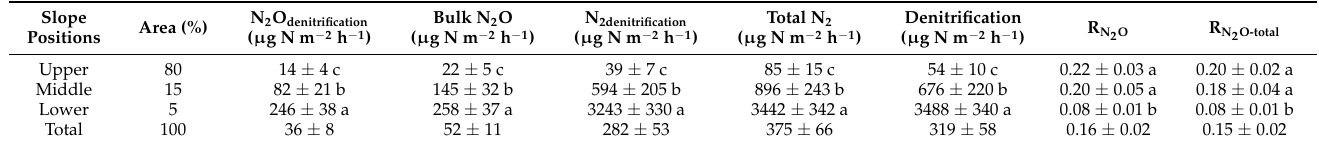
Figure 4. Mean fluxes of bulk N 2 O ( A ), N 2 O ( B ) and N 2 ( C ) produced from denitrifying NO 3 − pool over a 30 h incubation after in situ 15 NO 3 − addition (2.5 g 15 N m − 2 ) at different slope positions in the mixed forest of Qingyuan station in Northeast China. Values from different sites (1, 2, 3) and overall average are shown. Different lowercase letters indicate significant differences among slopes ( p < 0.05). Table 2. The area-weighed N 2 and N 2 O fluxes and ratios in the mixed forest of Qingyuan station in Northeast